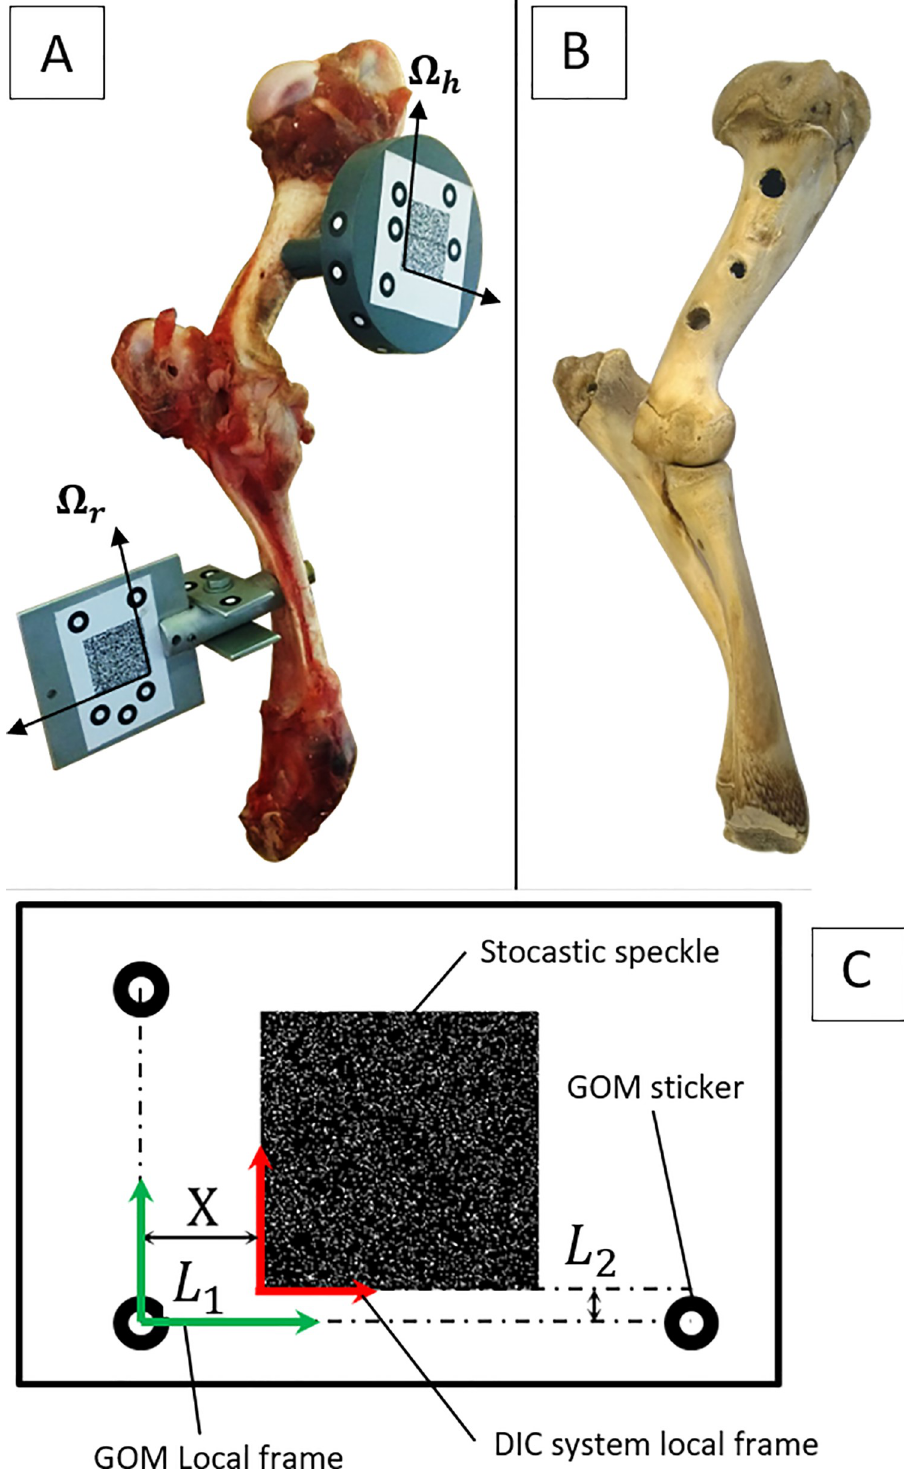
Fig 2. Sheep elbow specimens. (A) Fresh sheep elbow specimen with ligaments and synovial capsule, equipped with tracking clusters. (B) Sheep elbow specimen after removal of all soft tissue by boiling. (C) Composition of tracking clusters: Location of the speckle tracking mark relative to the 3D scanner